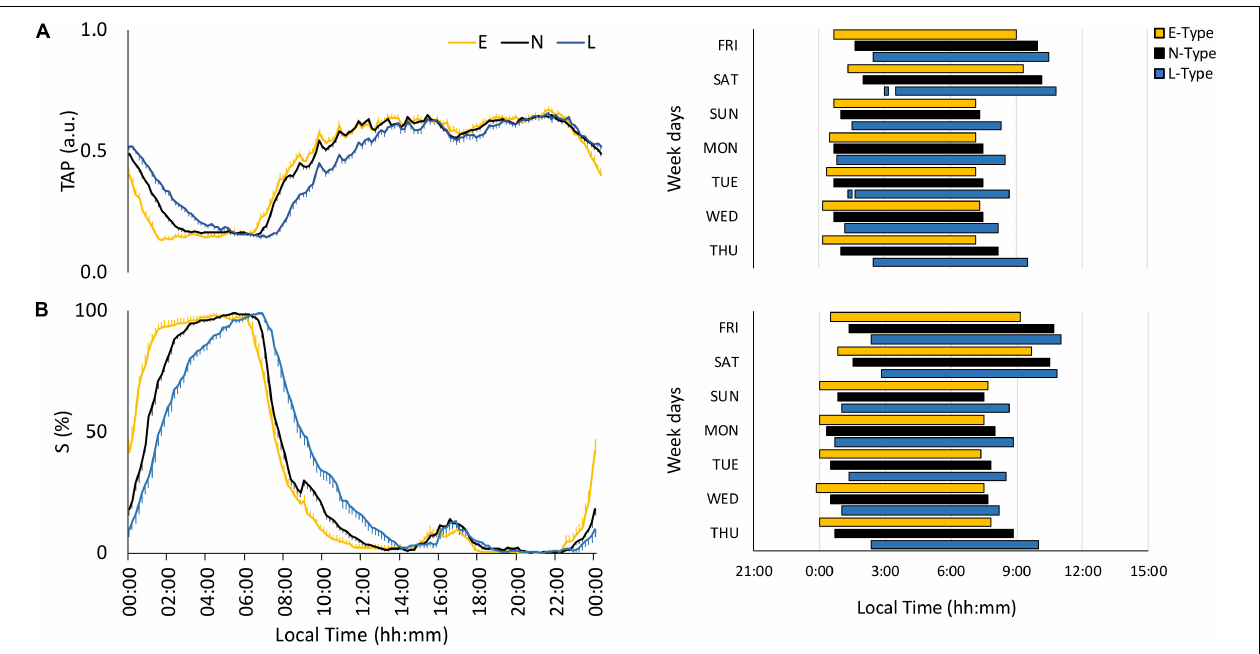
FIGURE 3 | Mean waveforms and actograms for early (E-types, in yellow; n = 20% of the total subjects), neither (N-types, in dotted black; n = 60% of the total subjects), and late-types (L-types, in blue; n = 20% of the total subjects) for: (A) TAP (total subjects = 159) and (B) sleep (S; total subjects = 148). Waveform data are expressed as mean ± SEM. TAP and sleep actograms correspond to the first and third tercile values, respectively (values corresponding to the rest